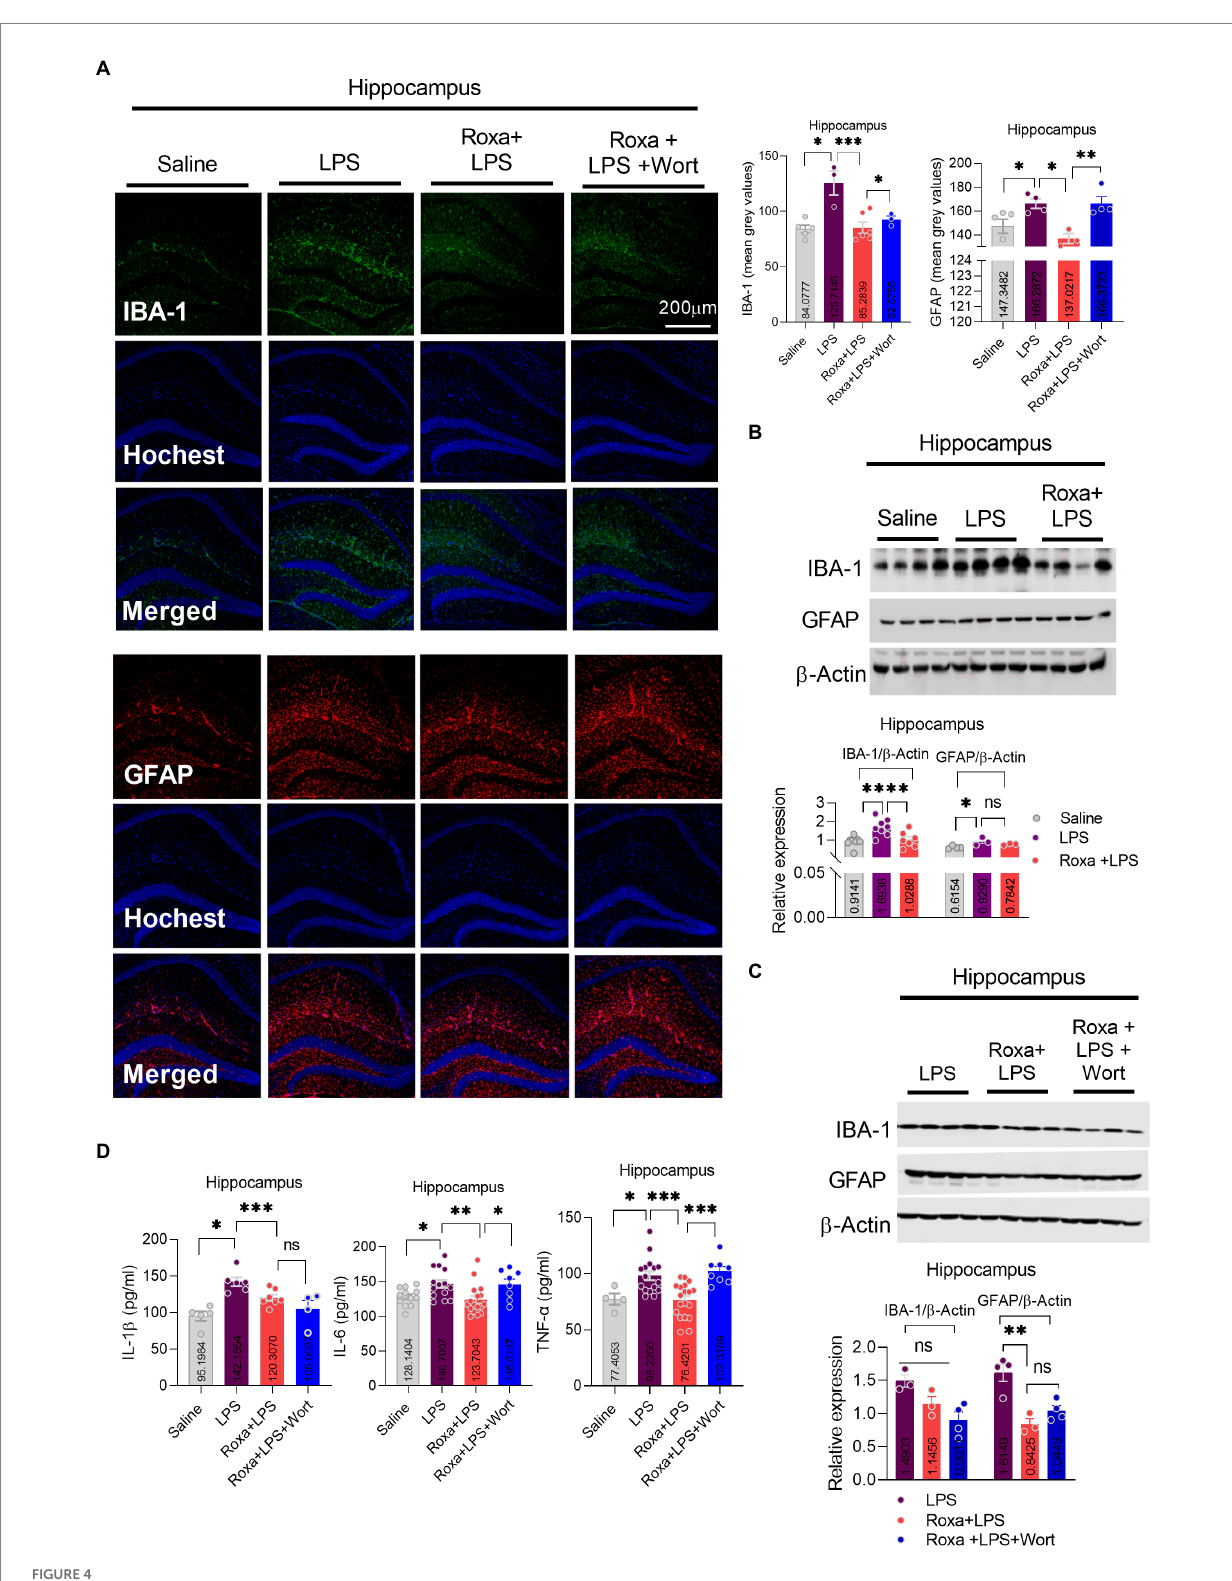
FIGURE 4 Roxadustat reduced LPS-induced neuroinflammation. (A) Microscopy results of Iba-1 expression in the different experimental groups of brain tissues, with respective bar graphs ( n = 6). Magnification 10×. The image data were collected from three independent experiments and were analyzed by ImageJ software. The differences are shown in the graphs. (B,C) Representative immune blots with individual level column graphs showing Iba-1 and GFAP expression n = 3–6. All the values were normalized with β -Actin. (D) Bar graphs showing the expression level of IL-1 β , IL-6, and TNF- α . Data were expressed as mean ± SEM, One-way ANOVA, followed by post hoc analysis. p = <0.05 were considered significant. * p < 0.05, ** p < 0.01, *** p < 0.001, **** p < 0.0001. ns: